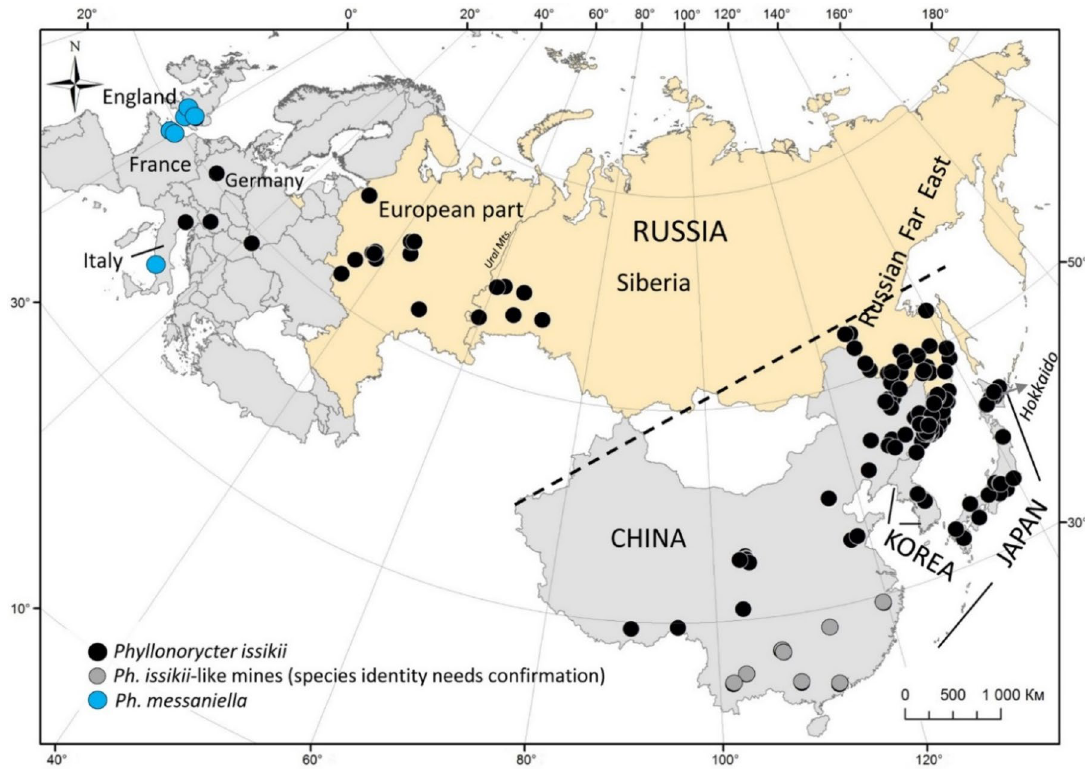
Figure 1. The localities where herbarium specimens of Tilia spp. carrying Phyllonorycter mines were collected in the Palearctic in the last 253 years. The dotted line divides Ph. issikii range to native (below the line) and invaded (above the line). The map was generated using ArcGIS 9.3 (Release 9.3. New York St., Redlands, CA. Environmental Systems Research Institute, http:// www. esri. com/ softw are/ arcgis/ eval- help/ arcgis-